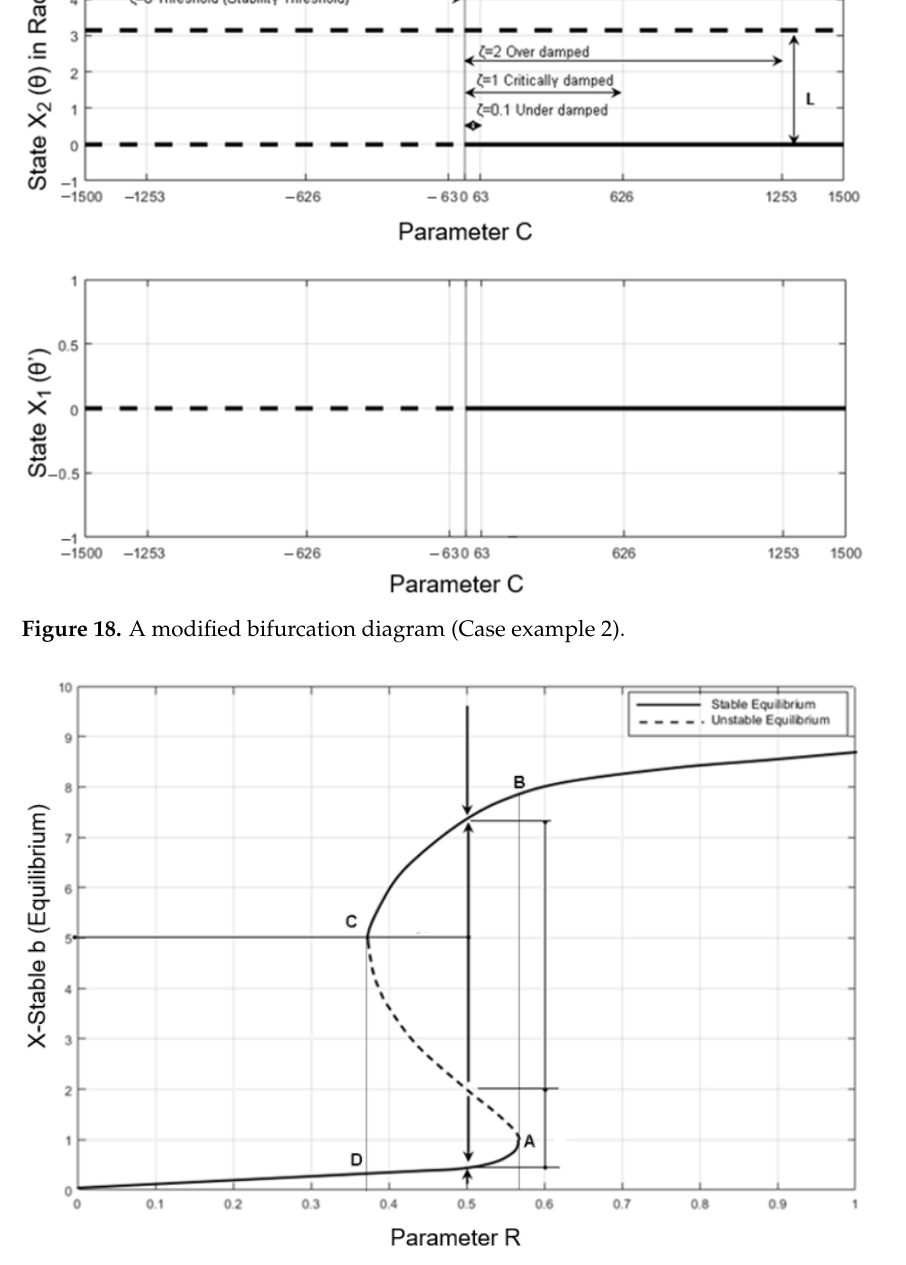
Figure 19. Spruce Budworm model S-shaped bifurcation for parameter (R) indicating a hard loss of resilience.